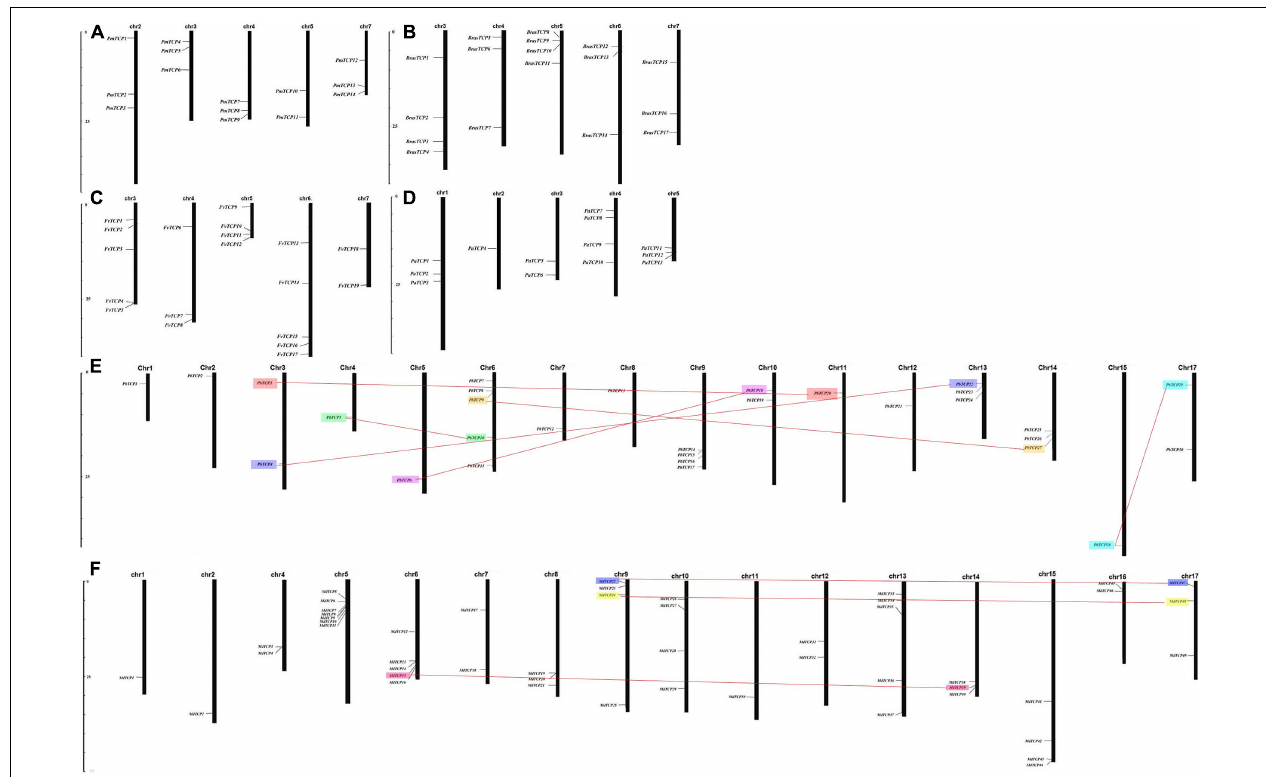
FIGURE 3 | Chromosomal locations of Six Rosaceae species. Chromosomal locations of TCP genes in (A) Prunus mume , (B) Rubus occidentalis , (C) Fragaria vesca , (D) Prunus avium , (E) Pyrus bretschneideri , and (F) Malus domestica. Duplicated gene pairs are connected with colored lines.